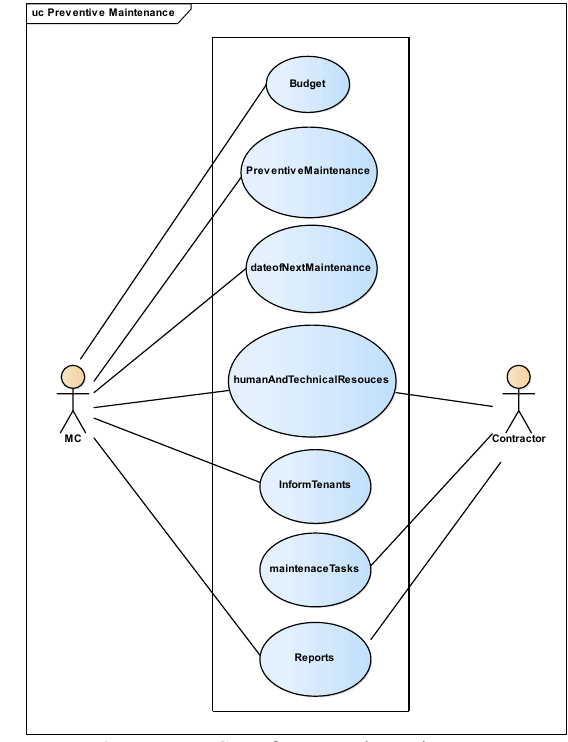
Figure 7. Use Cases for Preventive maintenance